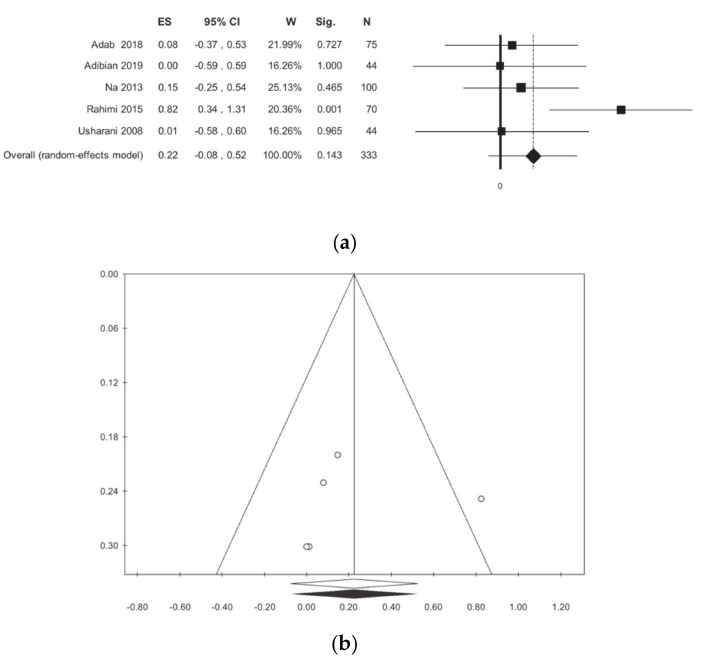
Figure 5. Meta-analysis results according to high-density lipoprotein (HDL): ( a ) forest plot ( b ) funnel